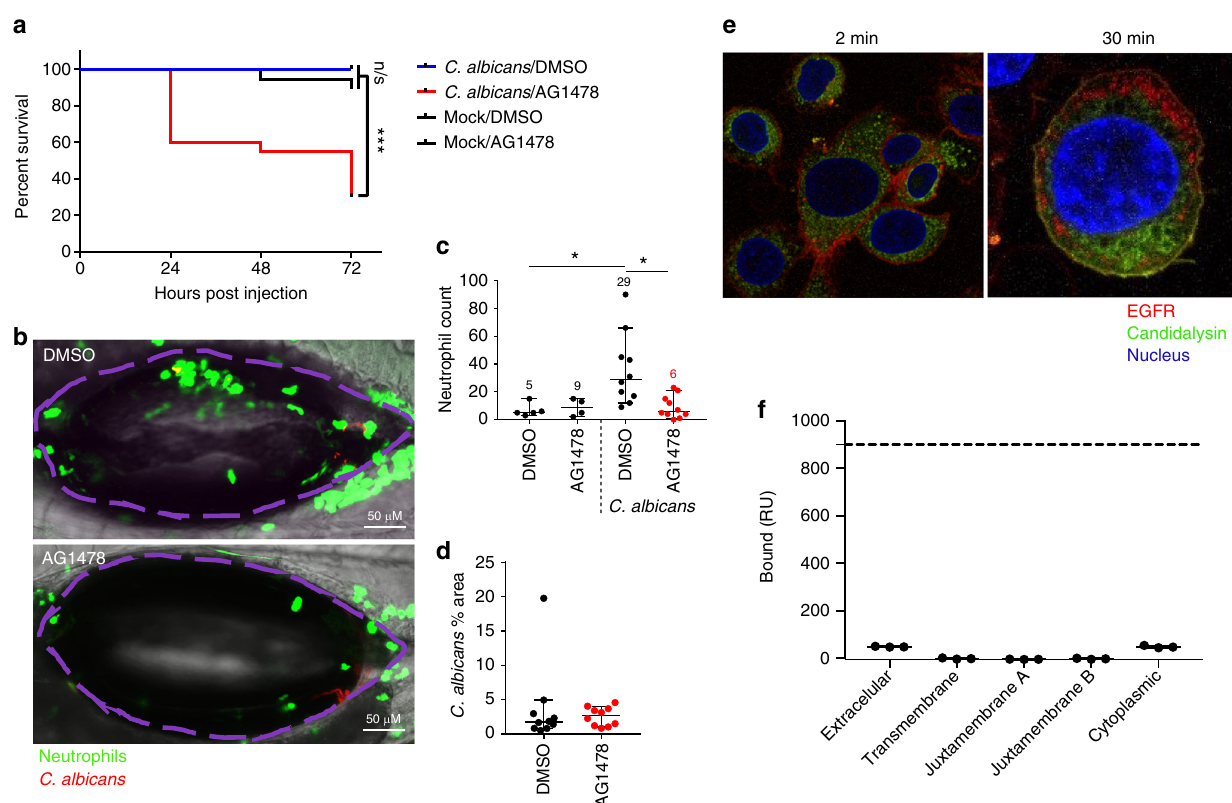
Fig. 3 Inhibition of EGFR suppresses neutrophil recruitment and enhances mortality in a zebra fi sh swimbladder model of candidiasis. Candidalysin does not bind EGFR. a Mortality: In the presence of AG1478 EGFR inhibitor, C. albicans-infected fi sh exhibited enhanced mortality with 70% death by day 3 p.i. (red), whereas all the infected vehicle treated fi sh survived (blue). b , c Neutrophil recruitment: EGFR inhibition resulted in signi fi cantly fewer neutrophils (green) recruited into the infected swimbladder (outlined in purple). Numbers in graph c provide the median neutrophil count per group. d Fungal load: No signi fi cant change in fungal burden was observed in the presence of AG1478 inhibitor, as quanti fi ed by the number of red pixels, normalised to the area of the swimbladder. Log-rank with a Bonferroni correction was used for ( a ), Kruskal-Wallis with Dunn ’ s post-test correction for ( c ) and Mann-Whitney for ( d ). Median and interquartile range are plotted in ( c , d ). * p <0.05, *** p <0.001, n.s. p >0.05. e Candidalysin does not co-localise with EGFR : Confocal images of TR146 cells show that at 2min post exposure, fl uorescently labelled candidalysin-488 (green) can be seen within the cell cytoplasm whilst EGFR (red) remains at the cell surface. At 30min post toxin exposure, although both EGFR and candidalysin are found within cells, no co-localisation was observed, and staining patterns are distinct for each. Confocal point images have a 91.36 µ mx90.79 µ m (left image) and 35.9 µ mx35.9 µ m (right image) fi eld of view. Images are representative of three